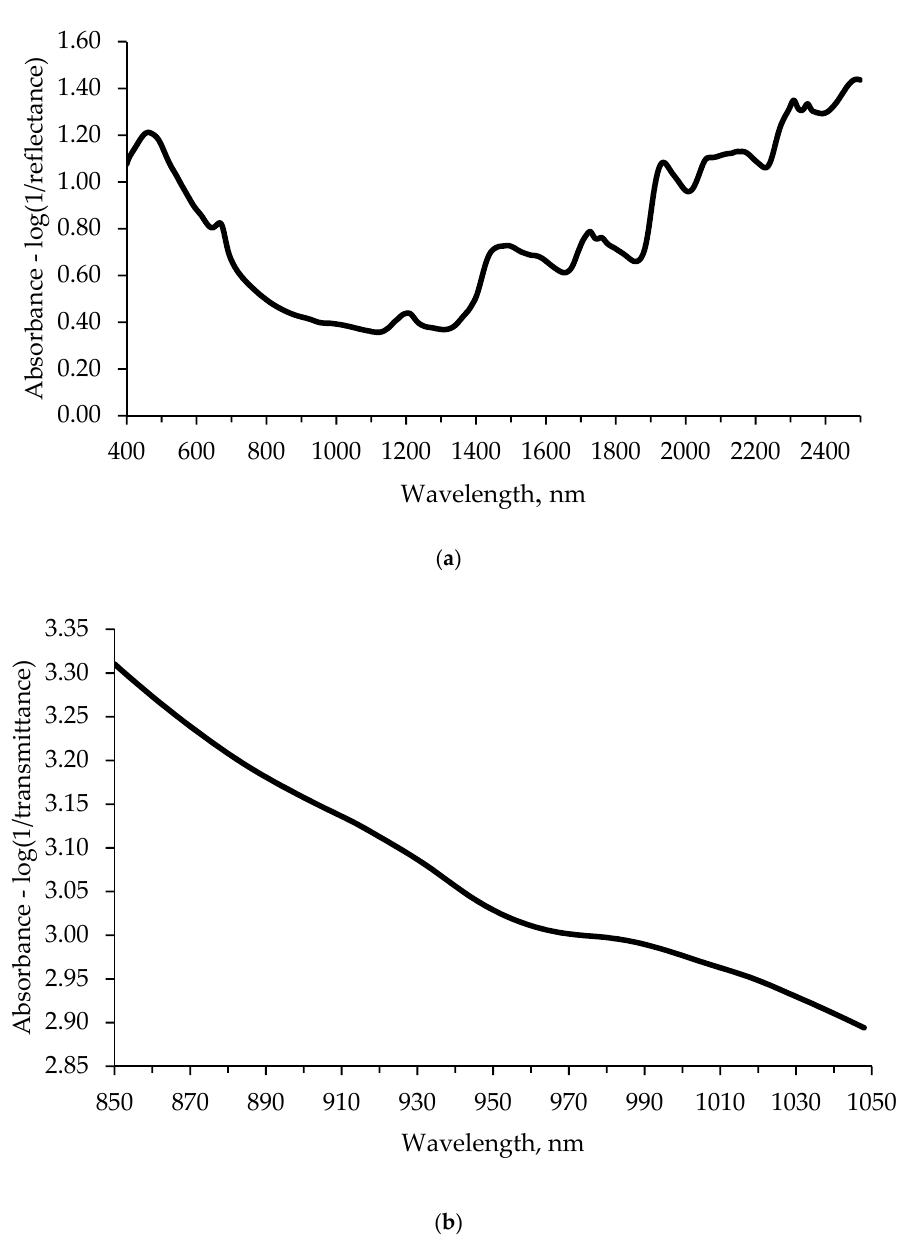
Figure 1. Average raw spectra of dry dog pet food using ( a ) visible / near-infrared spectroscopy in reflectance mode and ( b ) near-infrared spectroscopy in transmittance mode. Table 4. Fitting statistics of modified partial least square regression models using one-leave-out cross-validation ( n = 81) for total and gelatinized starch, neutral detergent fiber (NDF), acid detergent fiber (ADF), and acid detergent lignin (ADL) content (g/100g DM) in extruded dry dog food with visible and near-infrared reflectance spectroscopy (Vis-NIR) and near-infrared transmittance spectroscopy (NIT).